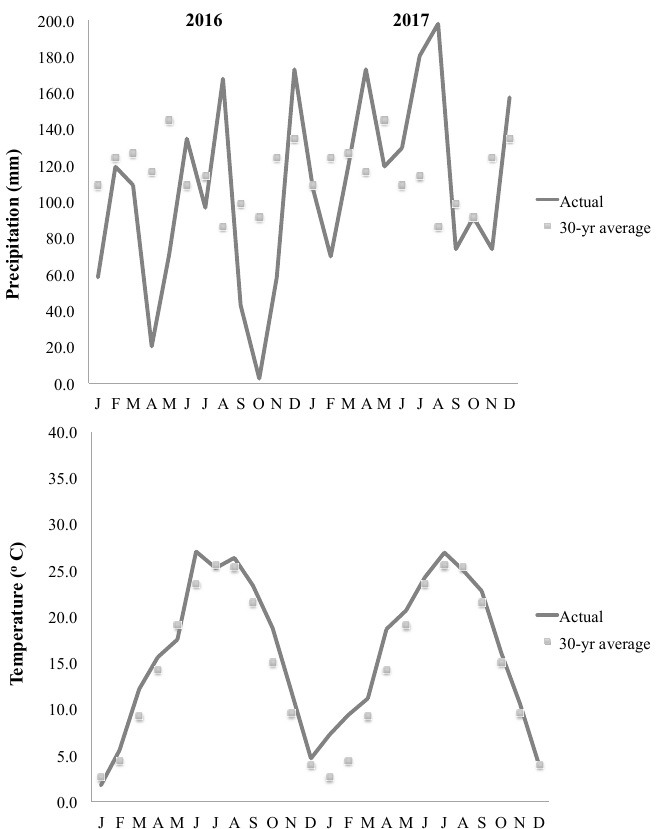
Figure 1. Weather for Middle Tennessee AgResearch and Education Center, Spring Hill, TN, 2015–2017, including 30-year average.